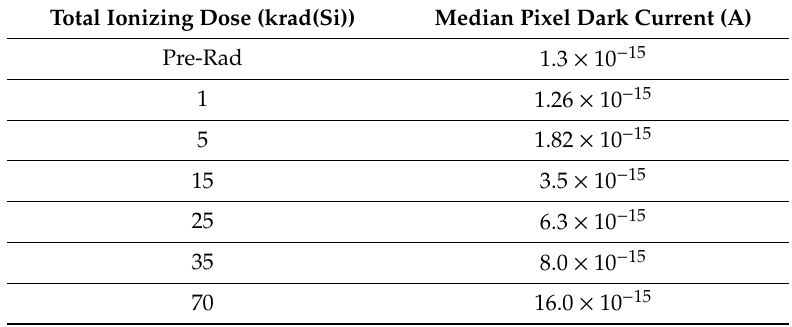
Table A1. FPA dark current change with total dose for HgCdTe 640x480-Format APD-Mode IR FPA (key environmental test-raising TRL to